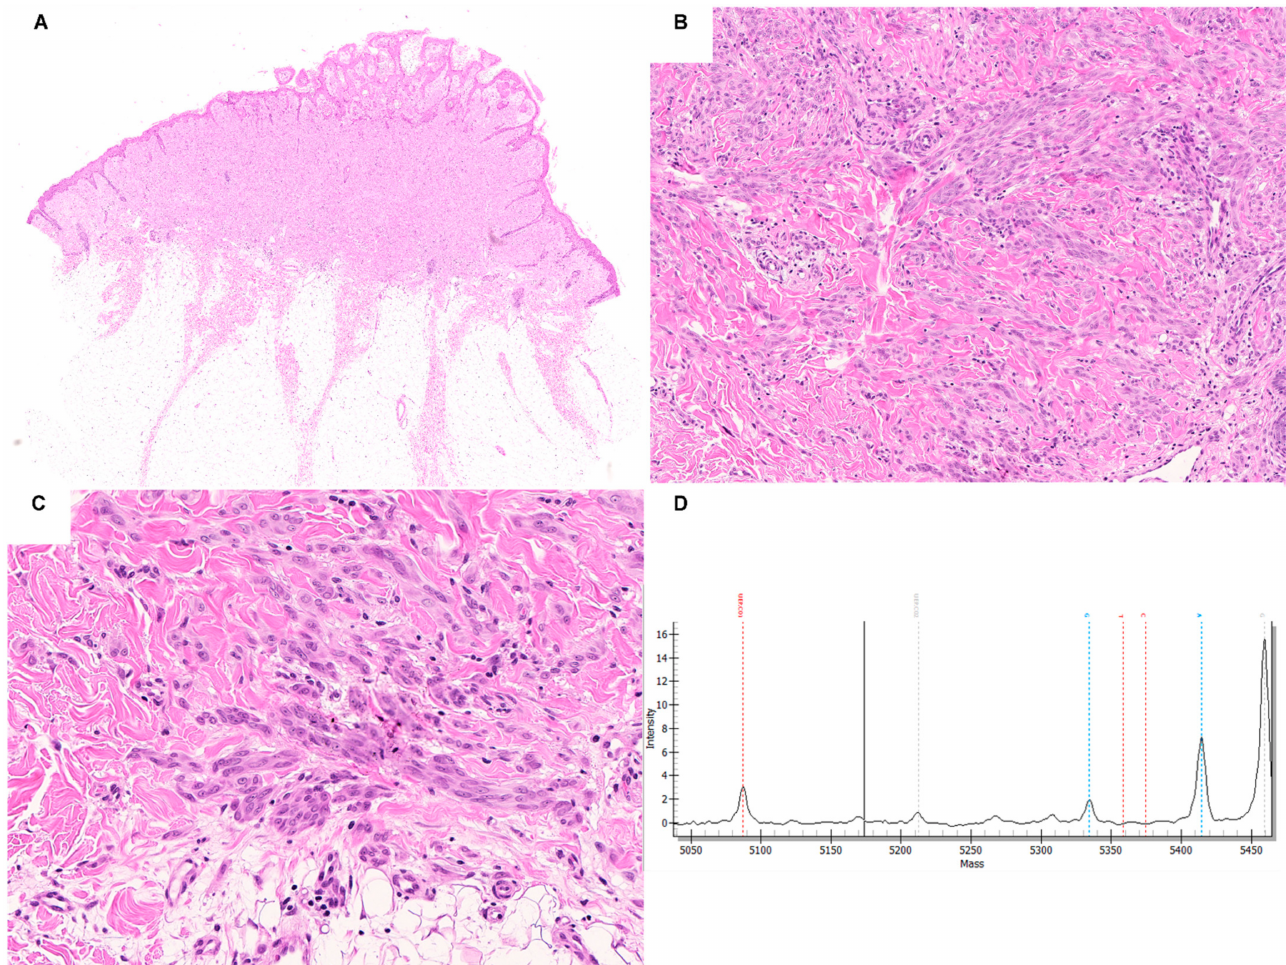
Figure 2. Photomicrographs of a Spitz nevus harboring HRAS mutation showing a symmetric, exophytic and dermal melanocytic proliferation with flat base, composed of fascicles of large spindle melanocytes with amphophilic cytoplasm, moderately pleomorphic vesicular nuclei, and distinct nucleoli, intermingled with thick collagen bundles ( A – C ) H&E staining; original magnification 10 × , 100 × , and 200 × , respectively). Mass Array graphic output showing the HRAS p.Q61R c.182A > G mutation detected by mass spectrometry-based analysis ( D